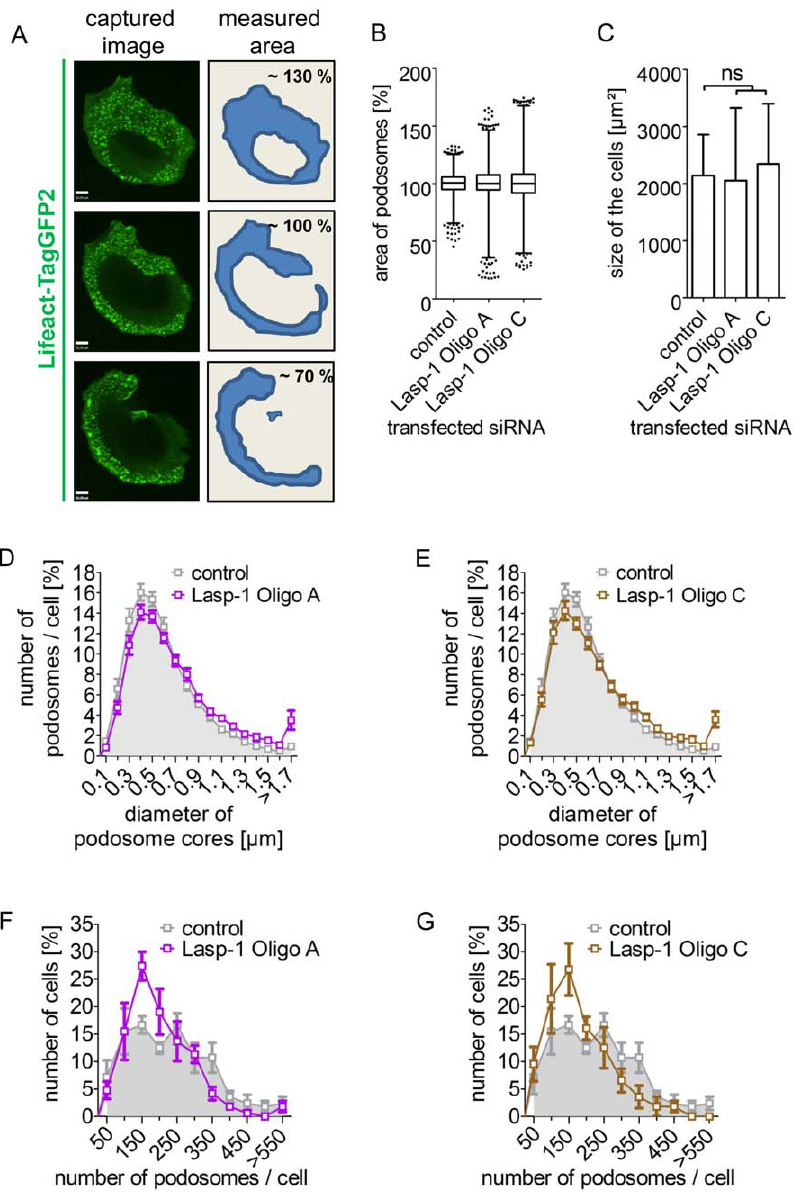
Figure 4. Impact of a siRNA-mediated knockdown of Lasp-1 on podosome numbers and structure in macrophages. Primary human macrophages were treated with control siRNA or Lasp-1 specific siRNA (Oligo A or C). ( A–C ) Podosome-covered area was analyzed by life cell imaging, with example shown in (A). Pictures were taken every 30 sec. over 30 min. (n=3 6 4 cells). Average area per cell was set at 100%. Values were plotted as box graphs, with whiskers from 1–99% (B). Note higher variability of podosome-covered areas in cells treated with Lasp-1-specific siRNA. (C) Measured cell size from cells used in (B). (means + SD; ns=not significant). ( D–G ) Diameter of the podosome cores (D, E) and number of podosomes per cell (F, G) were evaluated from cells treated with Lasp-1-specific siRNA (Oligo A (D, F; purple); Oligo C (E,G; brown)) or control siRNA (grey). Insets (d, e) show details taken from graph (means 6 SE, n=3 6 8 (D, E); means 6 SE n=3 6 56 (F, G)).